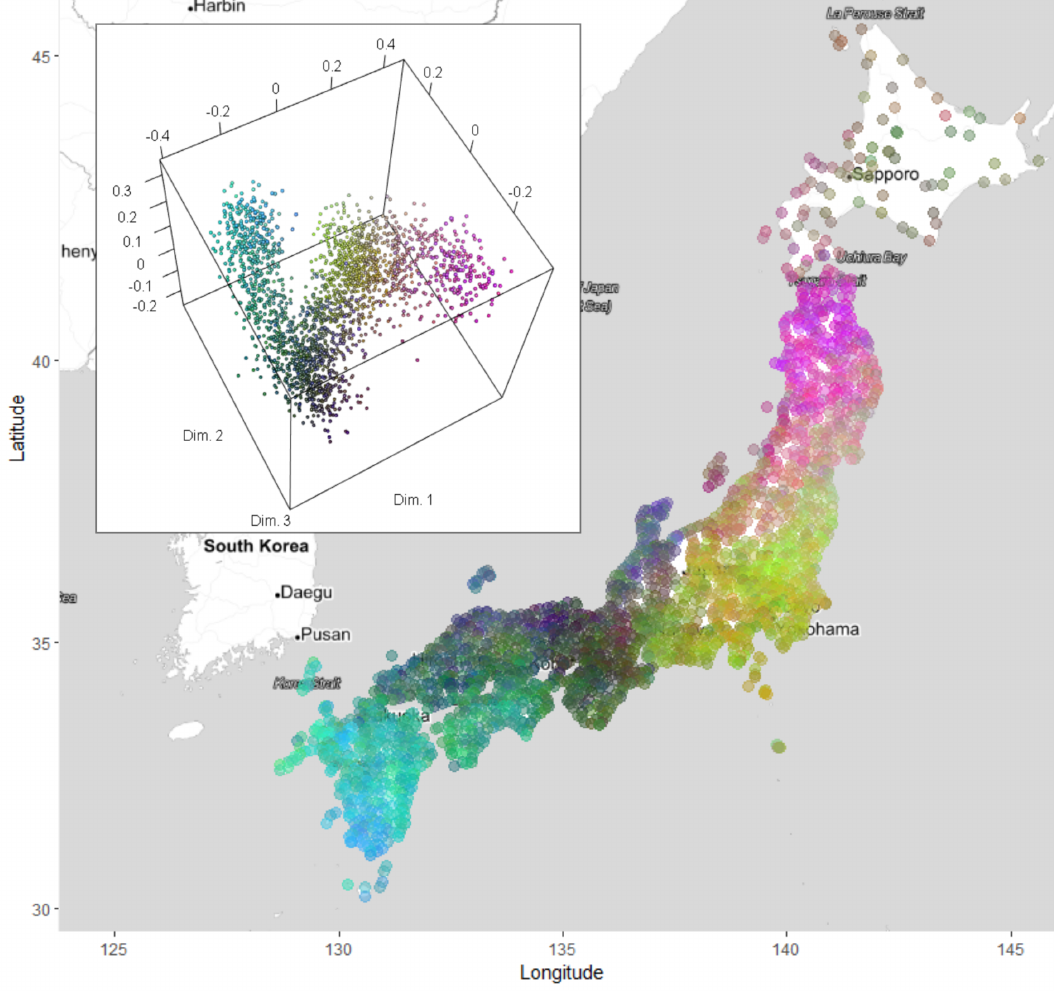
Figure 9. Multidimensional scaling map excluding Okinawa. The more similar colours are, the smaller the linguistic distance. The inset 3D plot shows the clustered relationship of the localities with regards to the three main